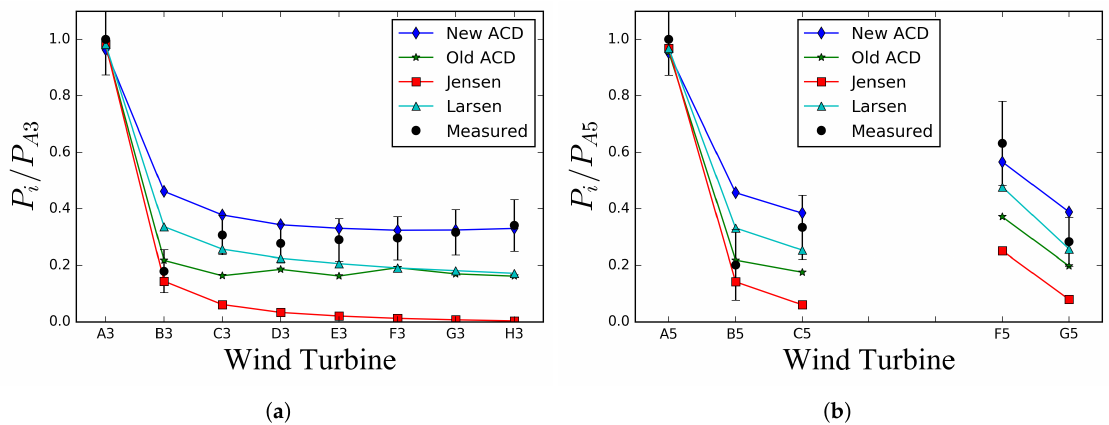
Figure 5. Normalized power production for the 120 ◦ direction ( a ) Row 3 and ( b ) Row